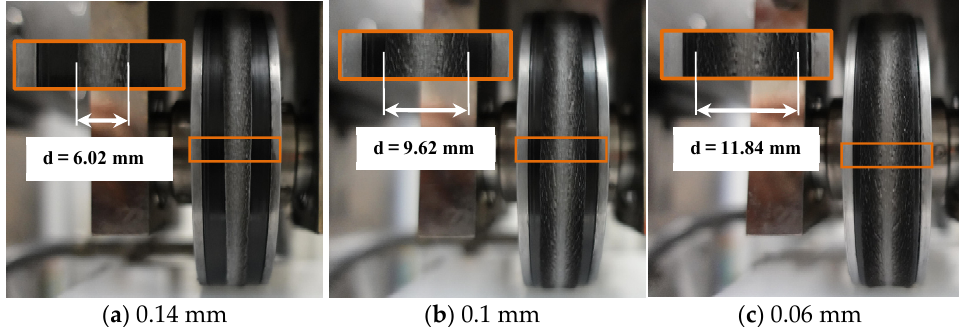
Figure 15. States of the compound magnetic finishing fluid in the finishing area with different working gaps.